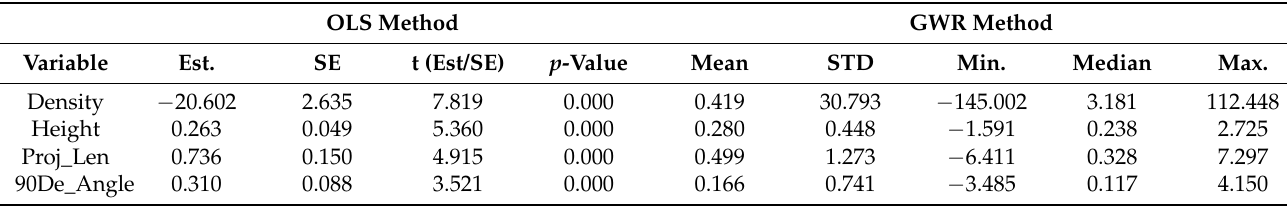
Figure 7. Influential areas and relative intervention methods.